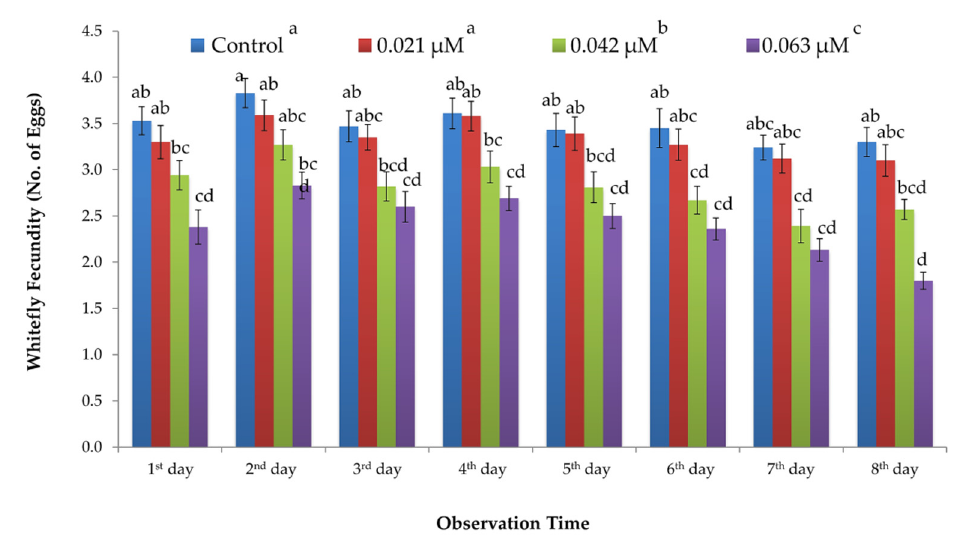
Figure 3. Fecundity rate (± SEM; n = 5 for each treatment) of whitefly ( B. tabaci ) recorded for different concentrations of partially purified protein derived from B. bassiana (ARSEF 2860). Different letters indicate significant difference among treatments (univariate ANOVA; SNK test at α = 0.05). (cf. Table 2).